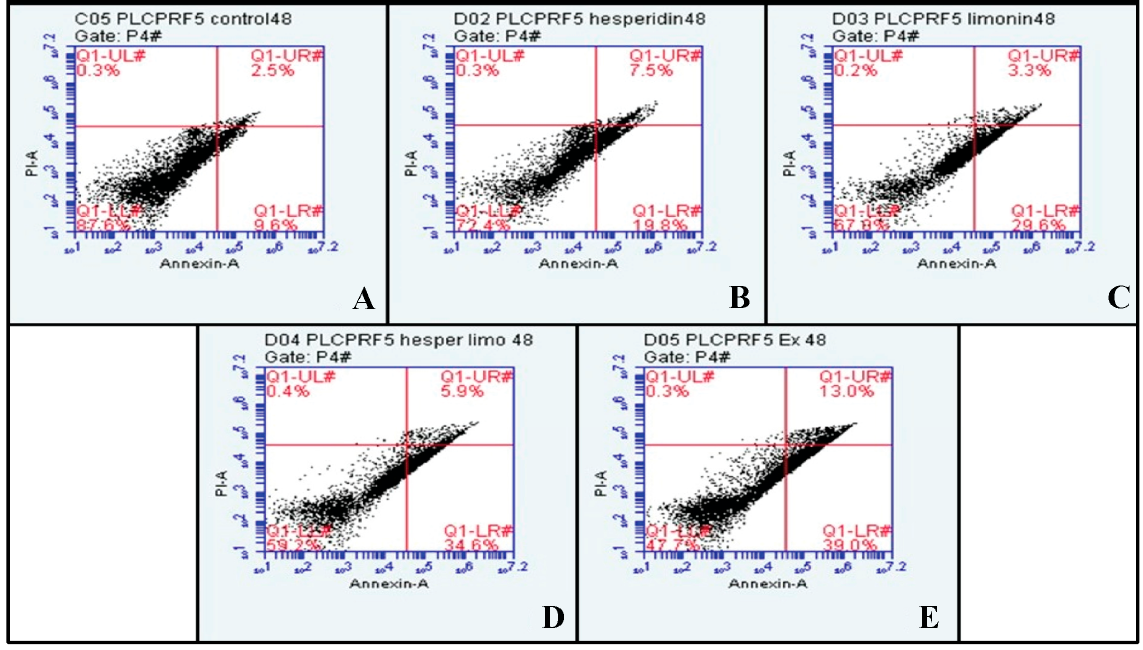
Figure 8. The dot plots of PLC/PRF/5 human hepatocellular carcinoma cells from flow cytometry analysis of Annexin V FITC/PI at 48 hr in each treatment are ( A ) negative control (DMSO), ( B ) Hes- peridin at IC 50 , ( C ) Limonin at IC 50 , ( D ) Combination of Hesperidin and Limonin at IC 50 , and ( E ) lime peel ethanolic extract at IC 50 .